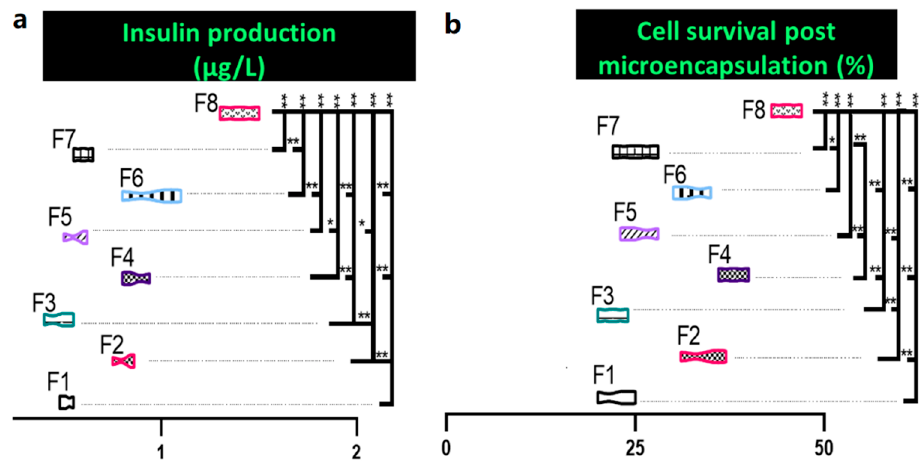
Figure 2. Insulin production ( a ) and cellular survival of encapsulated cells ( b ). Data are mean ± SEM, n = 3. * p < 0.05, ** p < 0.01.